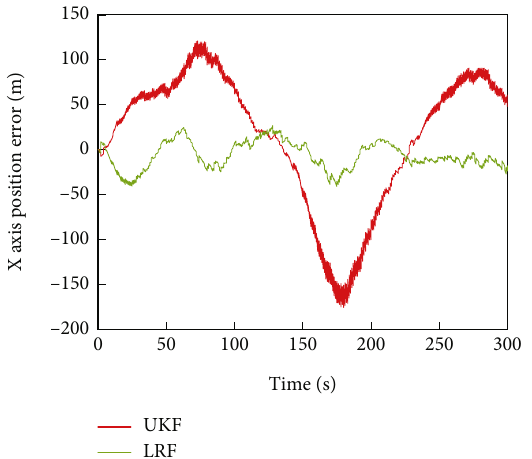
Figure 21: X -axis velocity error contrast curves